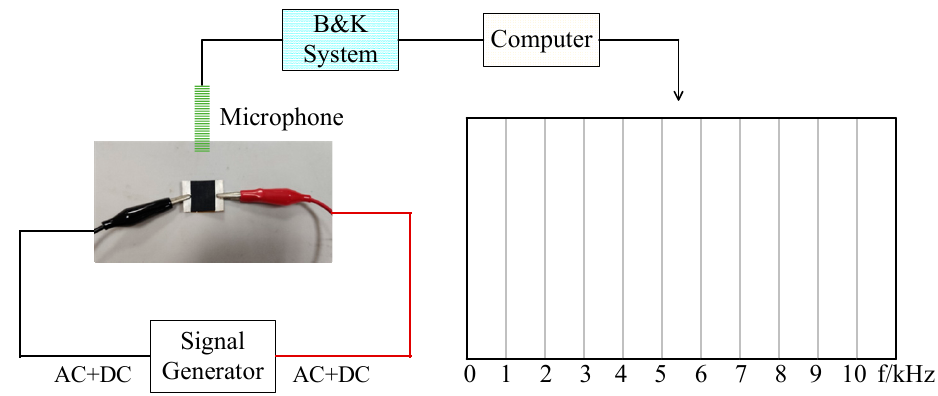
Figure 7. The diagram of measurement platform.